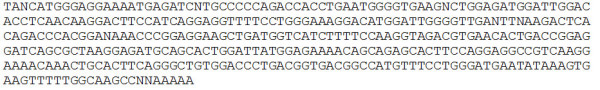
Sequencing results for the primer product for mouse stromal cell derived factor 4 (Sdf4) sequence.